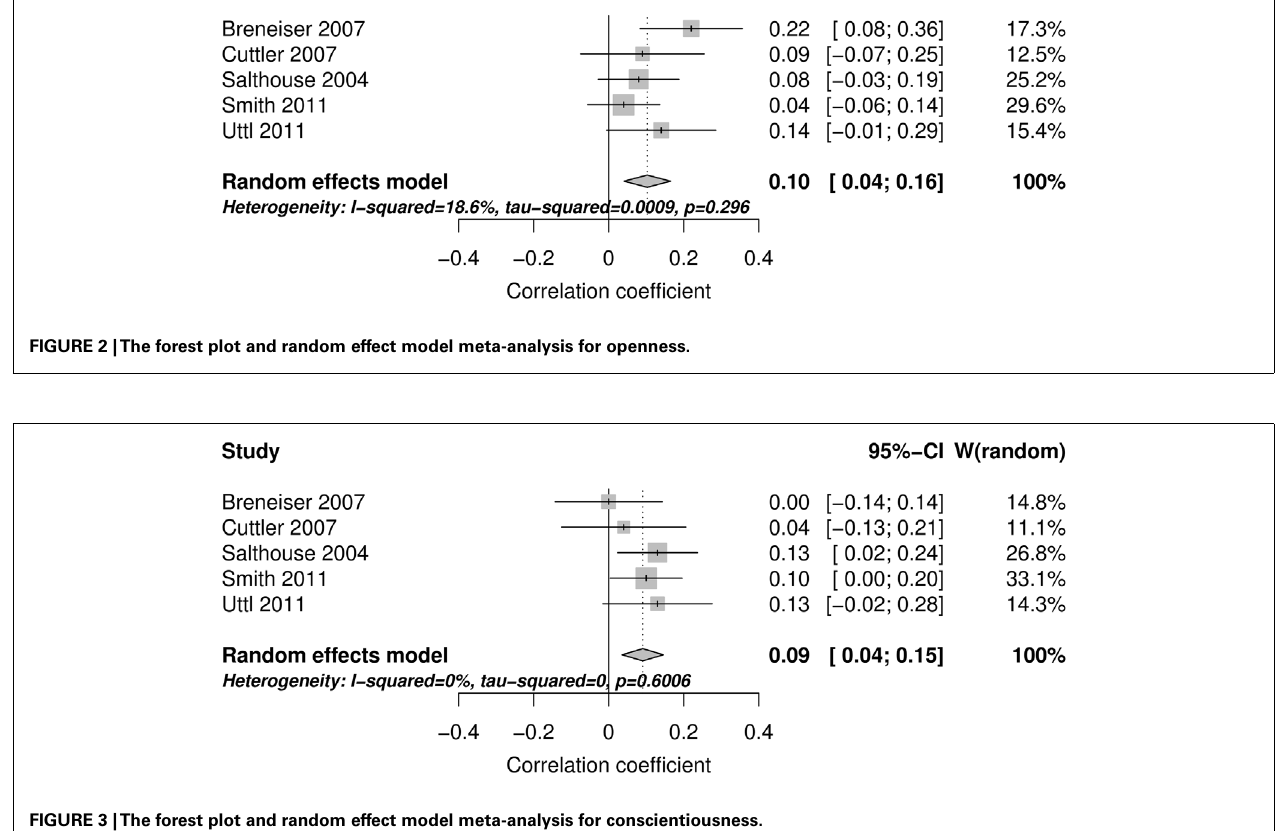
FIGURE 3 |The forest plot and random effect model meta-analysis for conscientiousness.